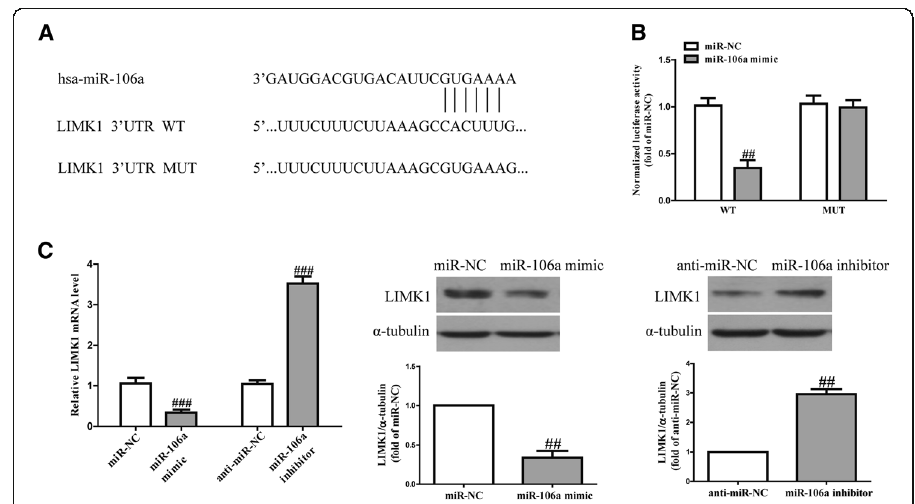
Fig. 3 LIMK1 is a direct target of miR-106a. SCC4 cells were transfected with an miR-106a mimic or inhibitor for 48 h. a Schematic representation of LIMK1 3 ’ UTRs showing the putative miRNA target site. b The analysis of the relative luciferase activities of LIMK1-WT and LIMK1-MUT. c The mRNA and protein expressions of LIMK1 were determined via quantitative RT-PCR and western blot, respectively. All data are presented as means ± SEM, n=6. ## p<0.01, ### p<0.001 vs. miR-NC or